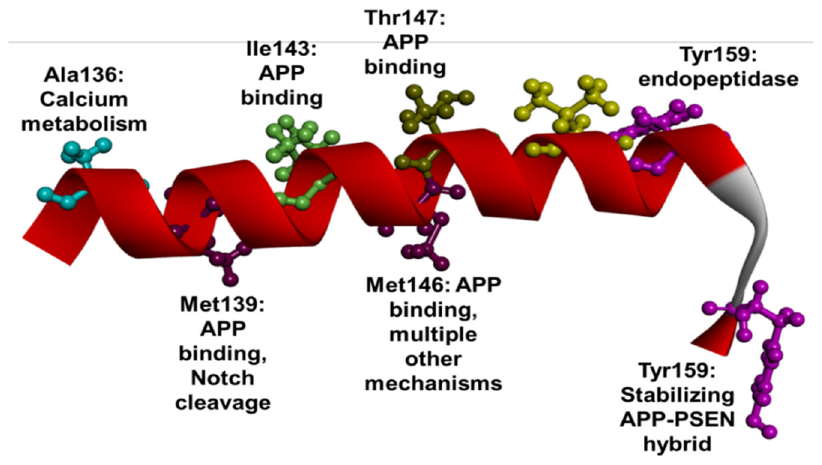
Figure 5. Potential significant residues in TM2 and HL2.